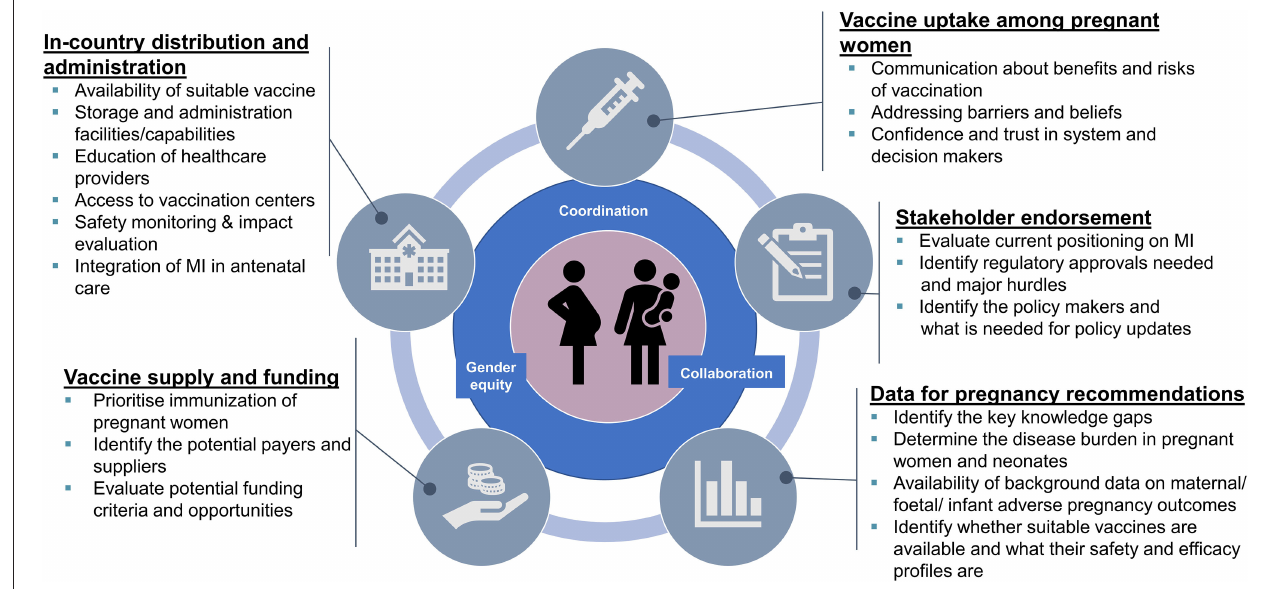
FIGURE 1 | Enabling factors for pandemic vaccination of pregnant women.